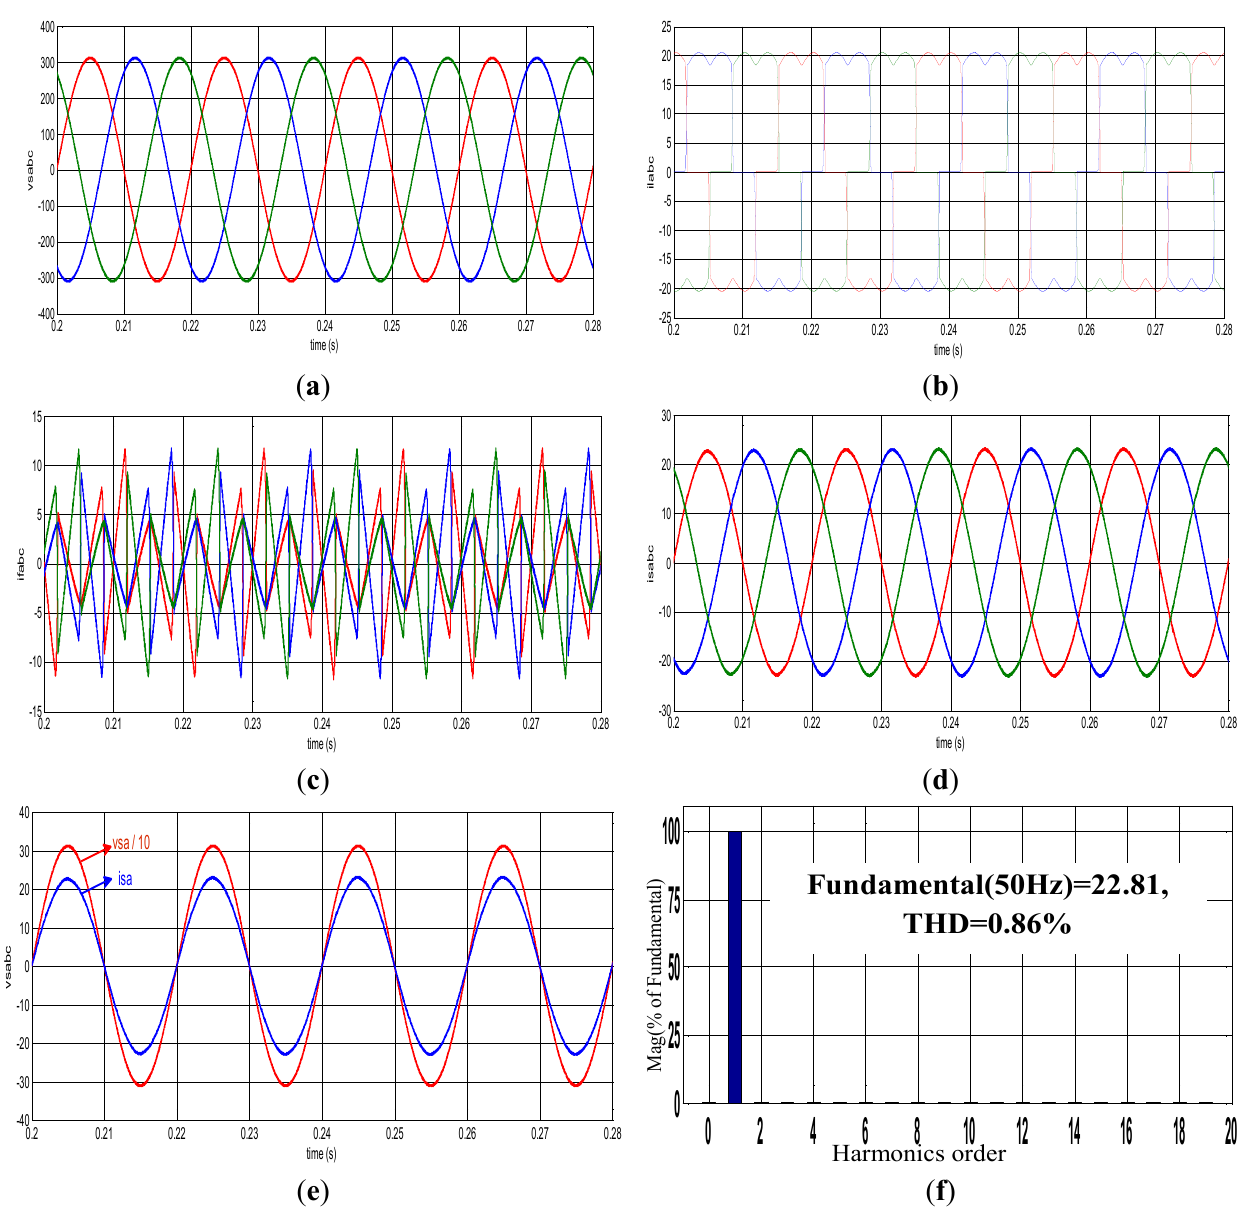
Figure 8. Simulation results for balanced sinusoidal grid voltage: ( a ) three-phase line voltages; ( b ) three-phase load currents; ( c ) three-phase filter currents; ( d ) three-phase line currents; ( e ) line voltage and current, phase-a; ( f ) frequency spectrum of line current,